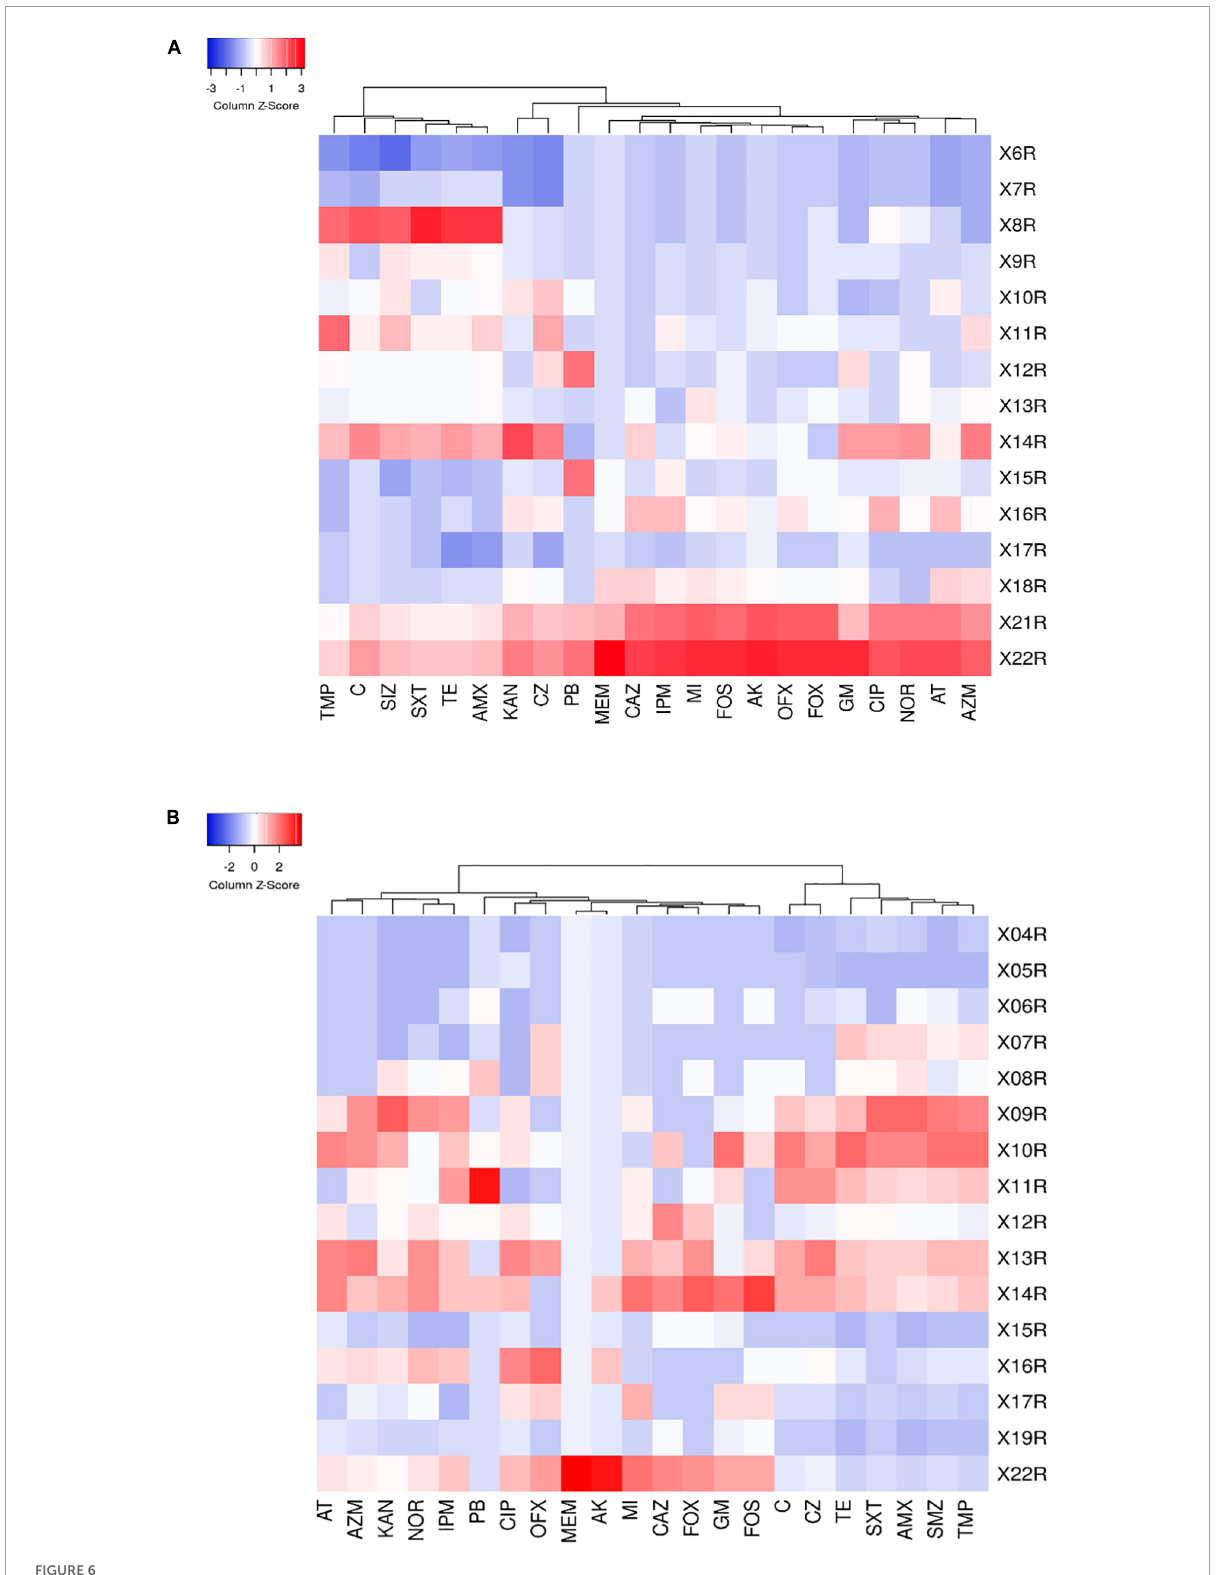
FIGURE6 (A) Heat map of multidrug-resistance of resistant strains in broiler farms. (B) Heat map of multidrug-resistance of resistant strains in laying farms. The right column shows the number of antimicrobials which were resisted by